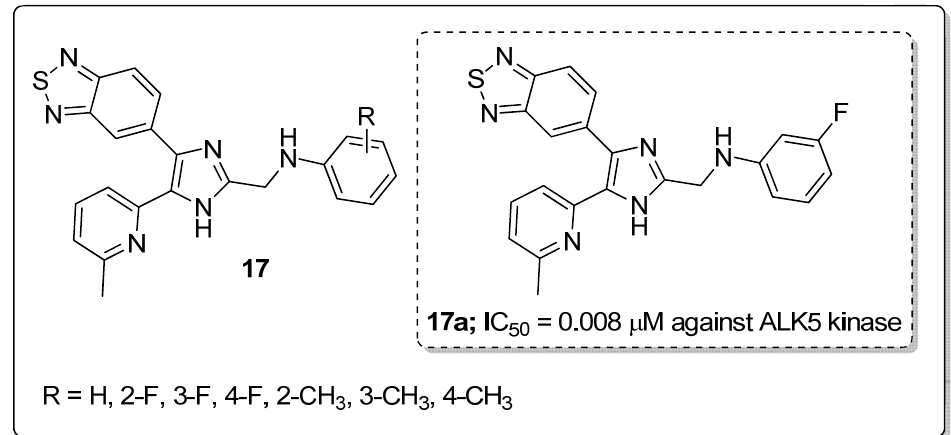
Figure 20. ALK5 inhibitory activity of the most active benzthiadiazole ‐ imidazole scaffold ( 17a ).